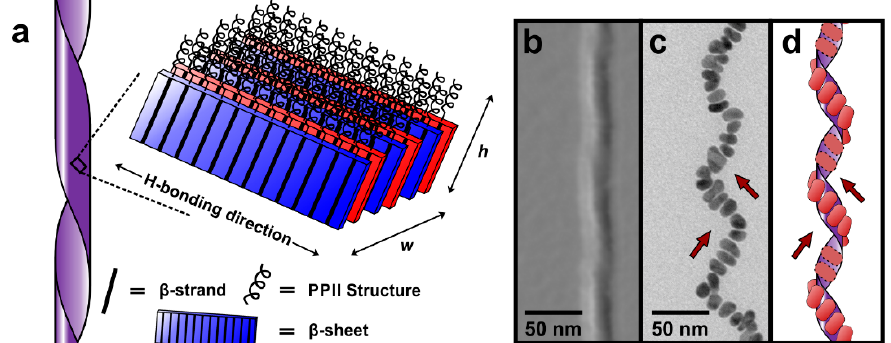
Figure 5. ( a ) Peptide amphiphile assembly model into a nanoribbon. ( b ) AFM image of the resulting assembled fiber. ( c ) TEM image of the gold nanorods oriented (arrows) into a helical pattern. ( d ) Proposed model of the gold nanorods associated to the outer surface of the peptide ribbon. Adapted with permission from [97]. Copyright © 2021, American Chemical Society.